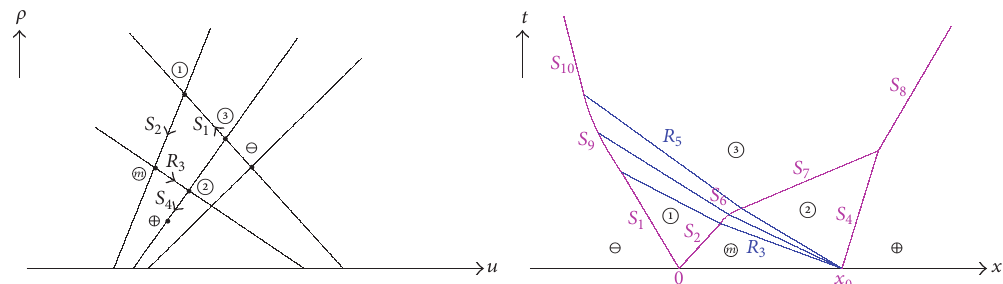
Figure 5: The interaction between 𝑆 + 𝑆 and 𝑅 + 𝑆 is shown when (𝑢 + , 𝜌 + ) ∈ 𝑉 4